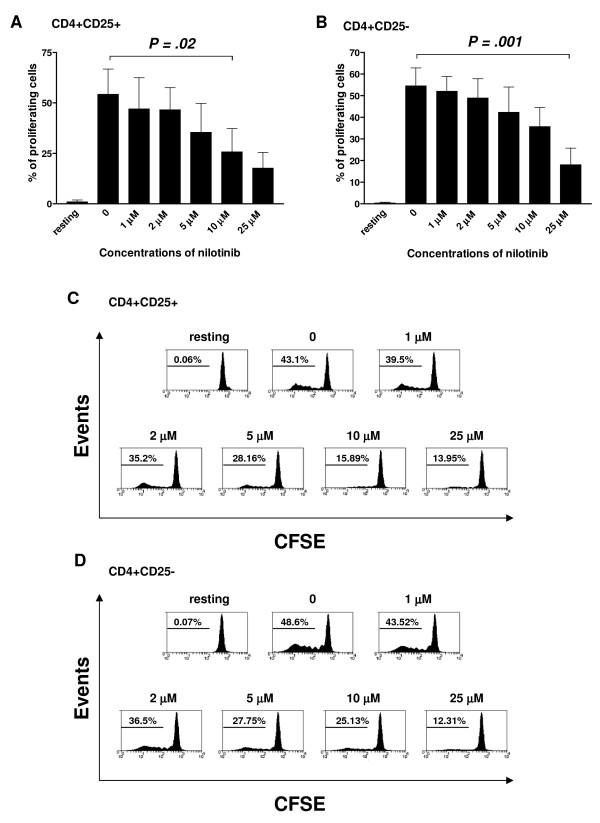
Nilotinib inhibits the proliferation of CD4+CD25+ T cells and CD4+CD25- T cells in a dose-dependent manner. CD4+CD25+ T cells or CD4+CD25- T cells were labeled with CFSE and cultured with different concentrations of nilotinib as indicated. After 4 days incubation, cells were harvested and stained with CD25 and FoxP3. Cell division was assessed by the dilution of CFSE. Panels A and B show the combined results from four independent experiments with similar results. Displayed are mean values ± SD. Panels C and D display the results of a representative experiment.